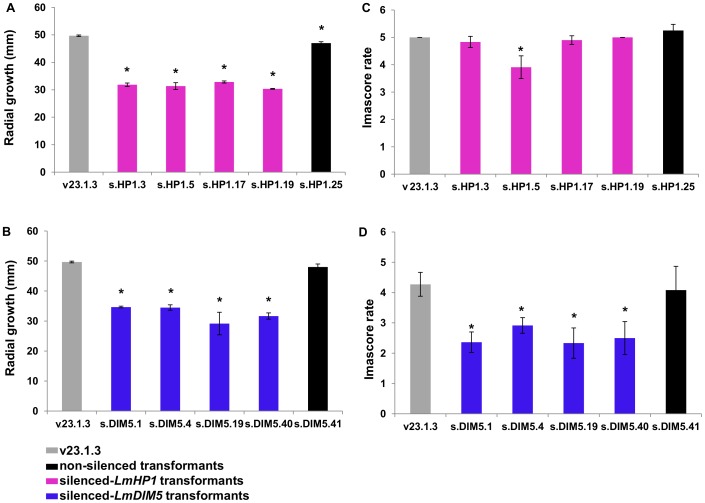
Effect of LmHP1 and LmDIM5 silencing on growth and pathogenicity of L. maculans.Radial growth and pathogenicity were assessed in the transformants and the wild type strain v23.1.3. Grey: wild type strain; black: non-silenced transformant; purple bars: silenced-LmHP1 transformants and blue bars: silenced-LmDIM5 transformants. (A) and (B) radial growth (mm) of the selected silenced-LmHP1 or silenced-LmDIM5 transformants (Figure 3) 10 days post inoculation on V8 agar plates. (C) and (D) pathogenicity assays of the selected silenced-LmHP1 and silenced-LmDIM5 transformants 14 days after inoculation on the susceptible cultivar Westar of B. napus. Results are expressed as the mean scoring using the IMASCORE rating scale comprising six infection classes (IC), where IC1 to IC3 corresponded to resistance and IC4 to IC6, to susceptibility [89]. Error bars indicate the standard deviation of two biological and technical repeats. Probability: * indicates P<0.05.